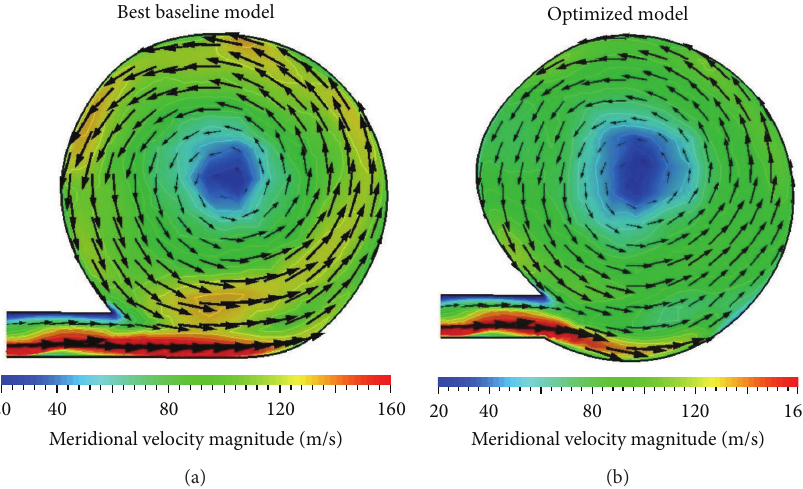
Figure 18: Meridional velocity magnitude at volute exit 𝜙 = 2𝜋 for the best baseline model (a) and optimized volute geometry (b) at ̇𝑚 corr = 0.19